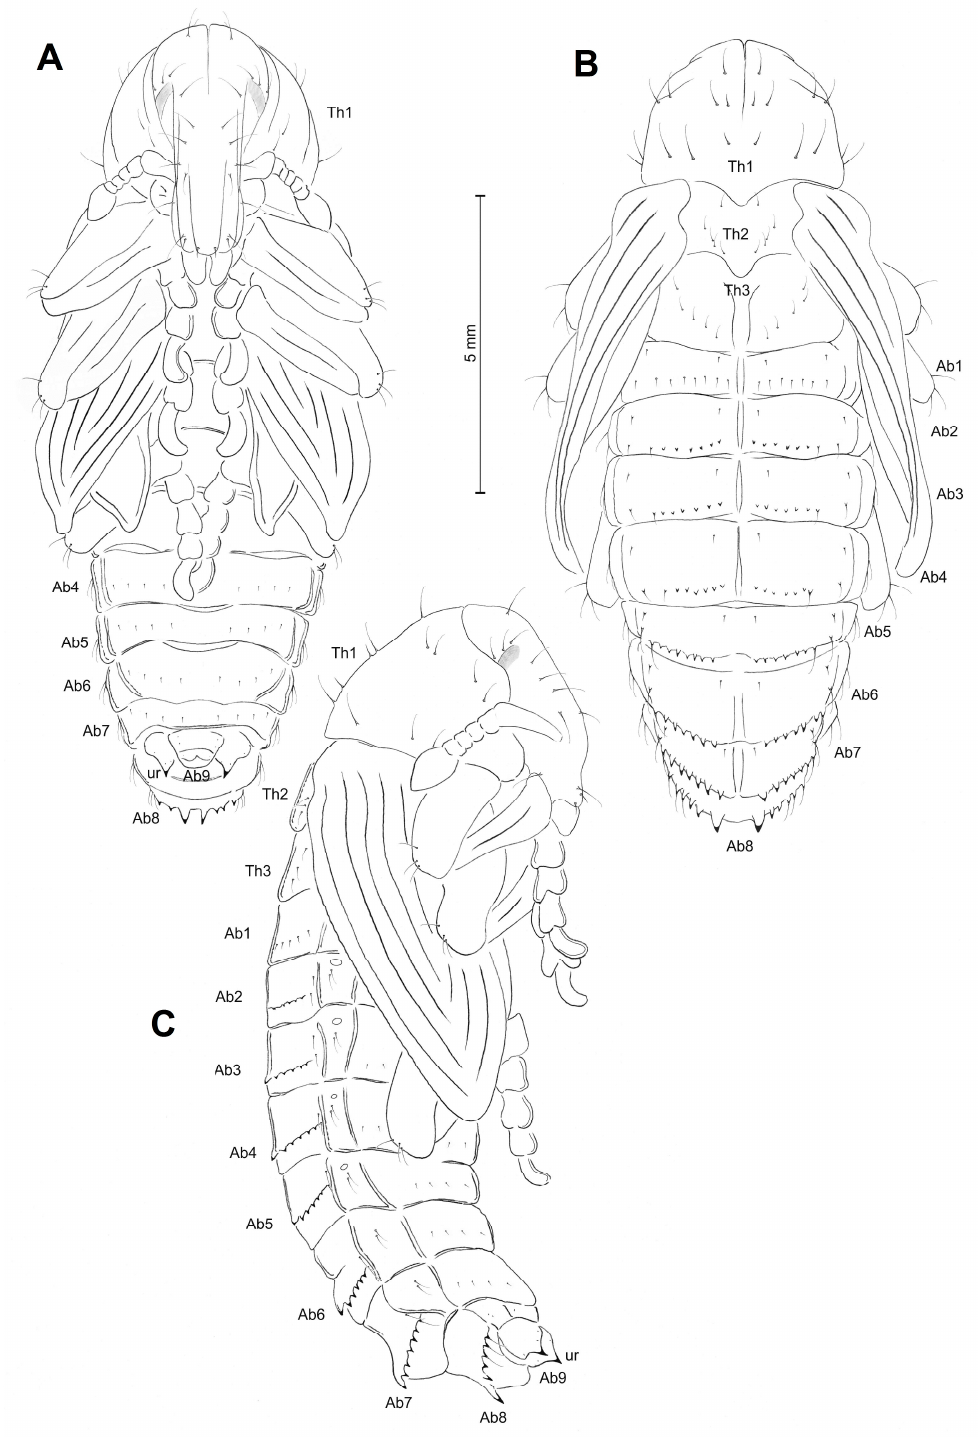
Figure 3. Cleonis pigra pupa, habitus. ( A )—dorsal view; ( B )—ventral view; ( C )—lateral view (Ab1–9—number of abdominal segments, Th1–3—number of thoracic segments, ur—urogomphi).